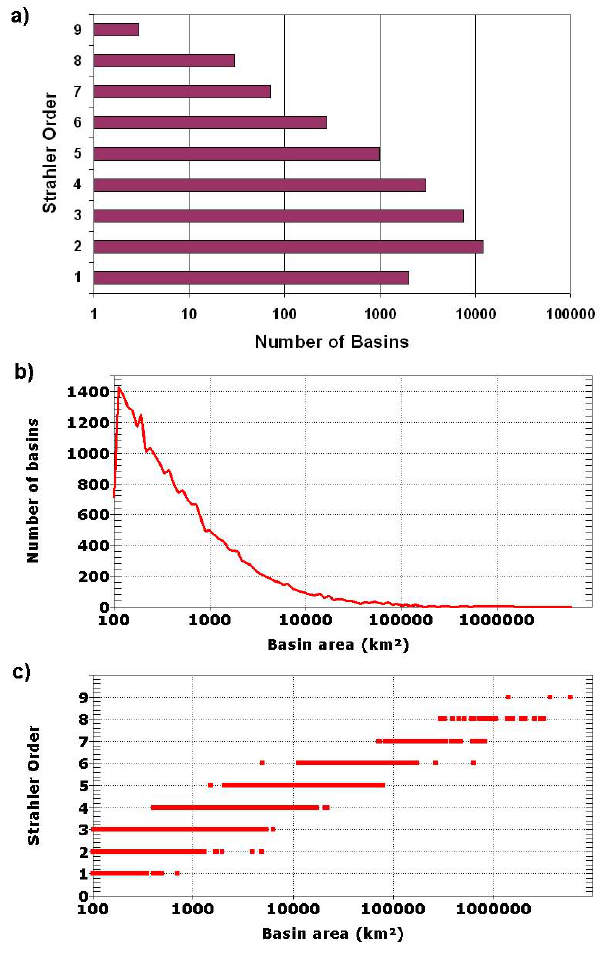
Fig. 4. (a) Histogram of Strahler order. (b) Histogram of basin area. (c) Basin area versus Strahler order.